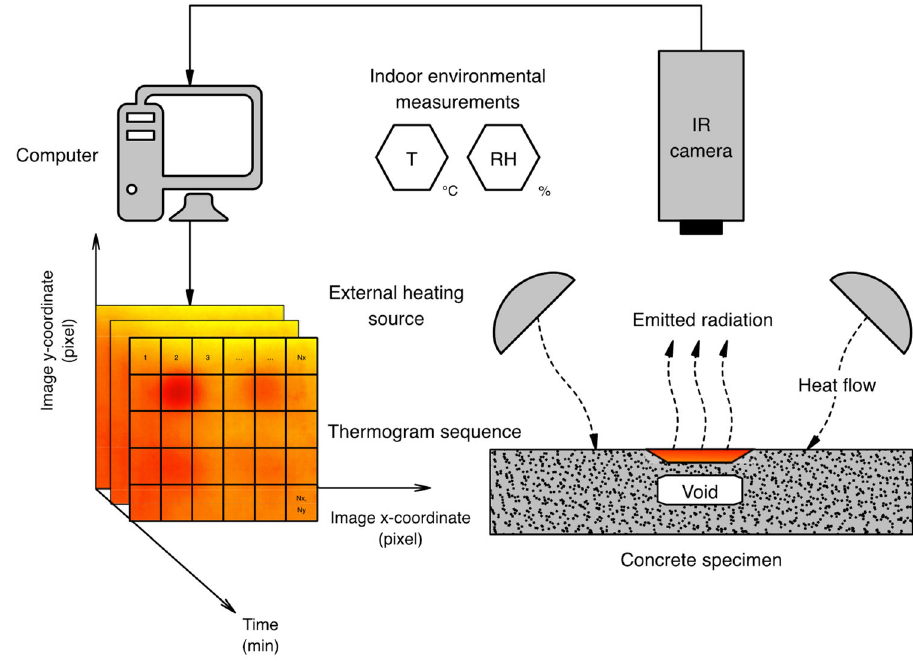
Figure 4. The schematic diagram for the active infrared thermography (IRT) setup used in the present study.